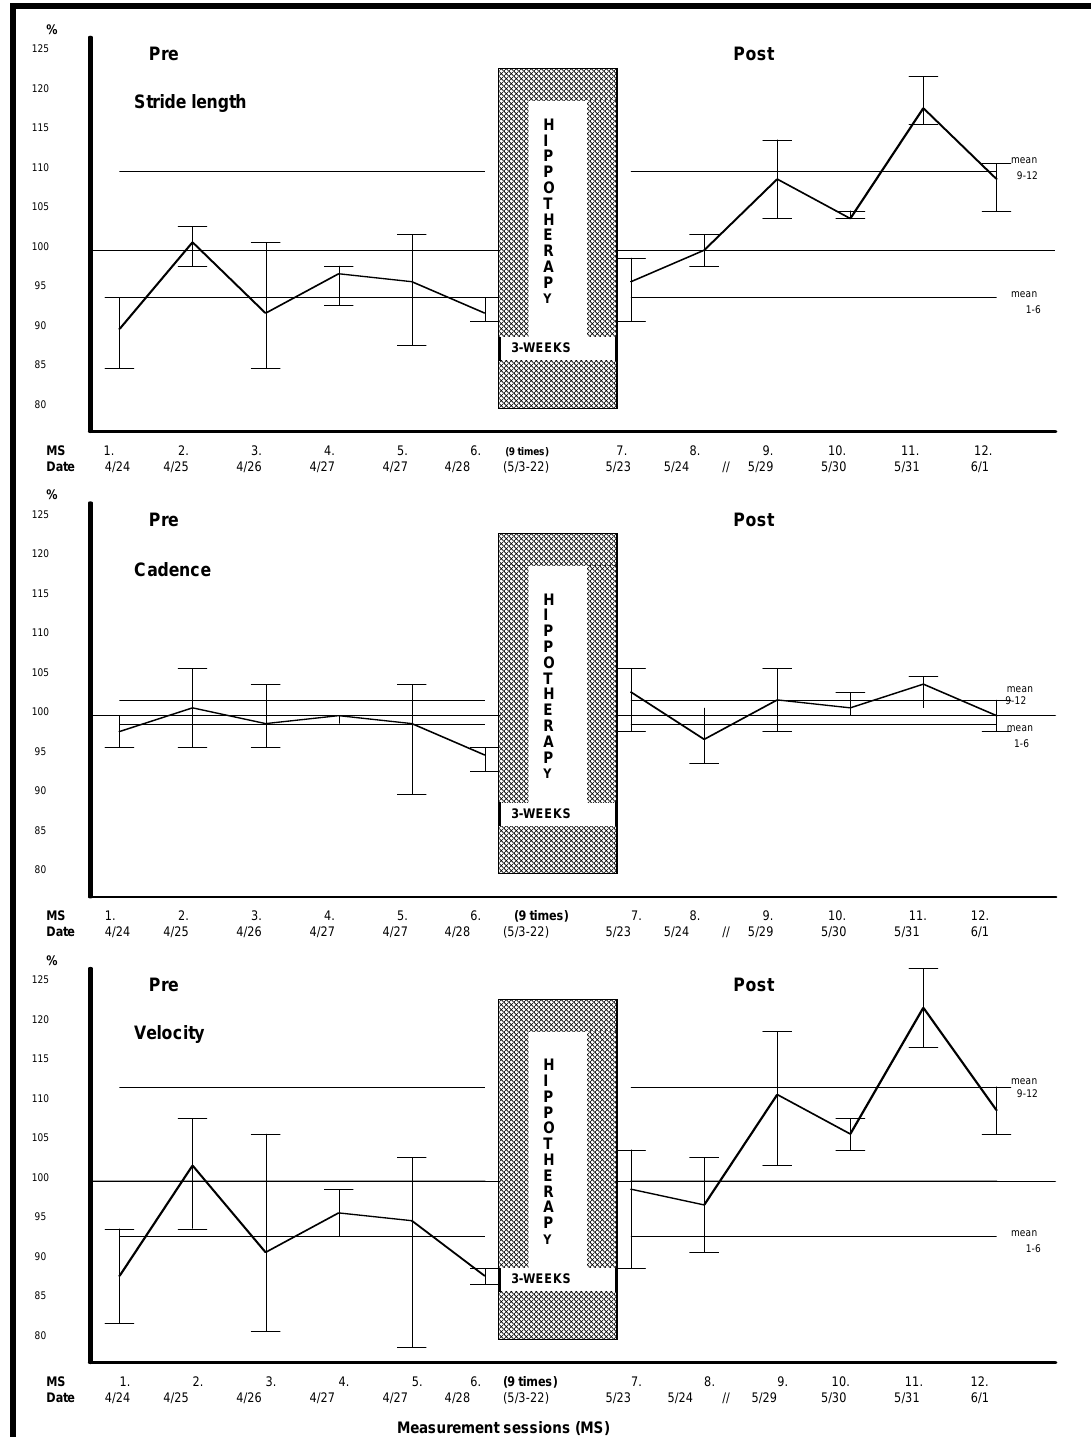
Figure 3. Donny: Gait parameters before (phase A), hippotherapy program (B), and after